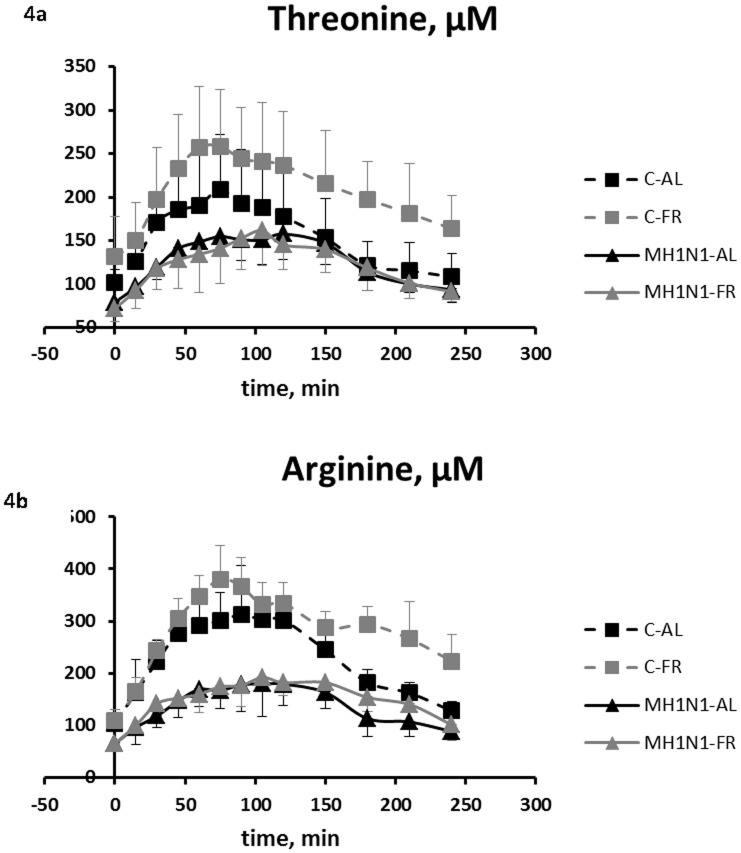
Postprandial kinetics of plasma threonine (3a) and arginine (3b) concentrations (µM) measured in pigs.Average plasma concentrations were measured after an overnight fasting and then during the 4ïc fluid administration in co-infected (MH1N1) and control (C) pigs fed ad libitum (AL) or feed restricted (FR): C-AL (black dashed line), C-FR (gray dashed line), MH1N1-AL (black solid line) and MH1N1-FR groups (gray solid line). Values are means +/− SD. P values for threonine: PI<0.05 from basal to 240 min; PFR<0.05 from 180 to 240 min; PI×FR<0.05 from 180 to 240 min. P values for arginine: PI<0.01 from basal to 240 min; PFR<0.05 from 150 to 240 min; PI×FR<0.05 from 180 to 240 min.